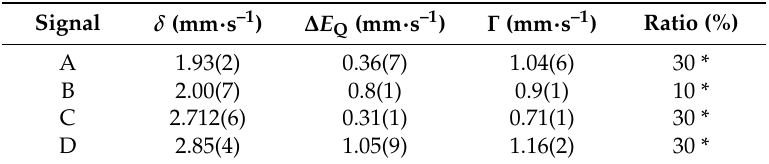
Table 4. Fitting parameters for the 119m Sn Mössbauer spectrum of 3 at 6 K; δ = isomer shift, ∆ E Γ = experimental line width. Parameters marked with an asterisk Q = electric quadrupole splitting, (*) were kept fixed during the fitting